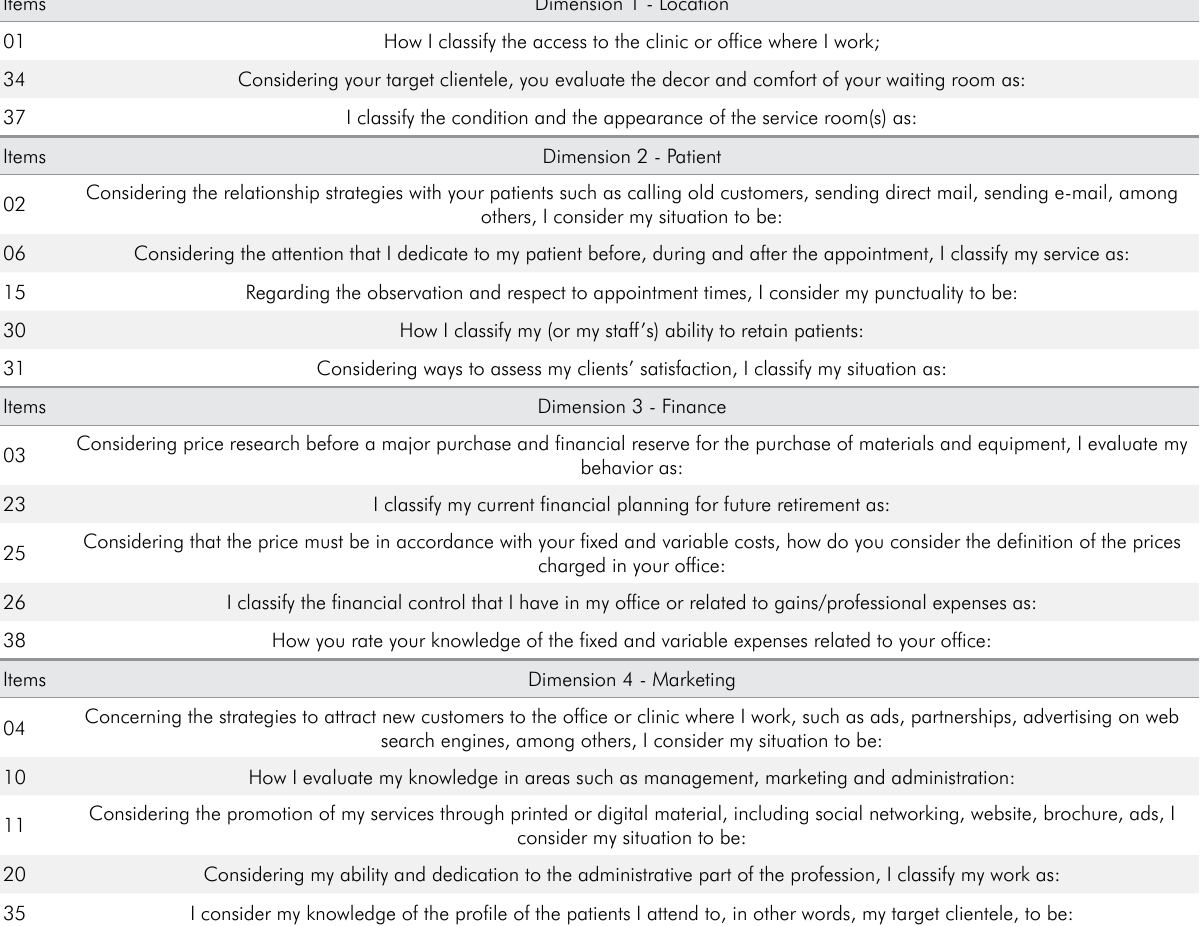
Table 1. DMS-BR: dimensions 1 to